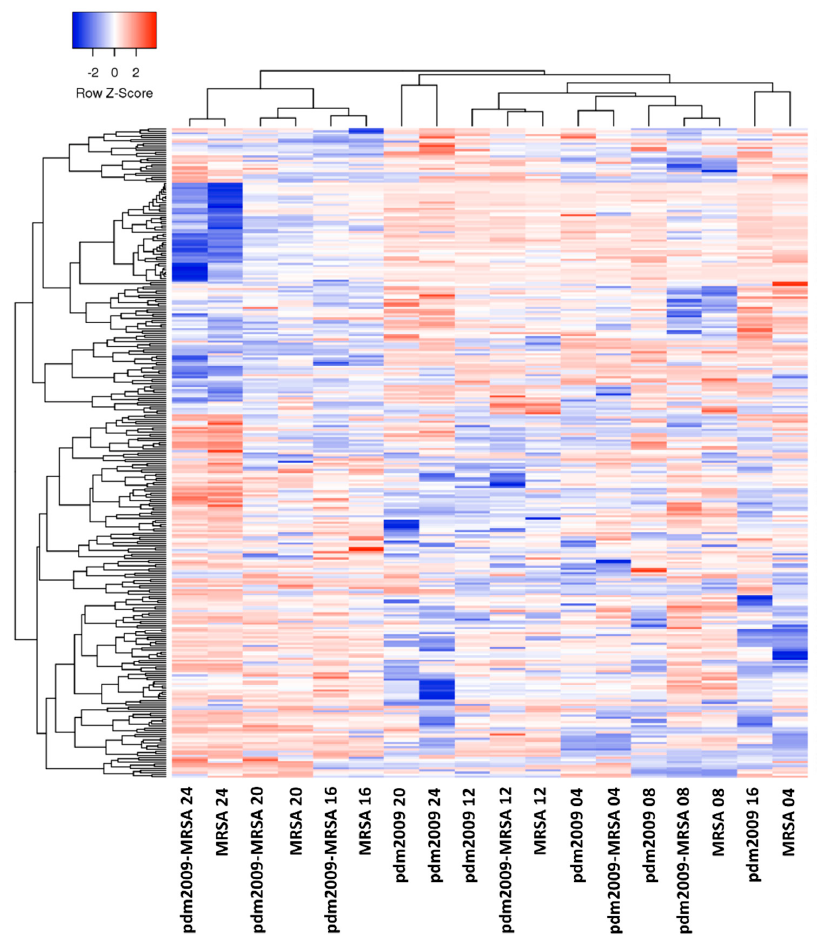
Figure 3. Background-subtracted temporal kinome responses of pdm2009, MRSA, and pdm2009-MRSA infection. Mock-infected kinome responses were subtracted from the time-matched infected samples. Fold change phosphorylation values are plotted for all kinase recognition sequences on the kinome peptide arrays. Clustering analysis was performed with the Heatmapper software suite. Z-score values represent fold change differences in phosphorylation as compared to the time-matched mock-infected control cells.